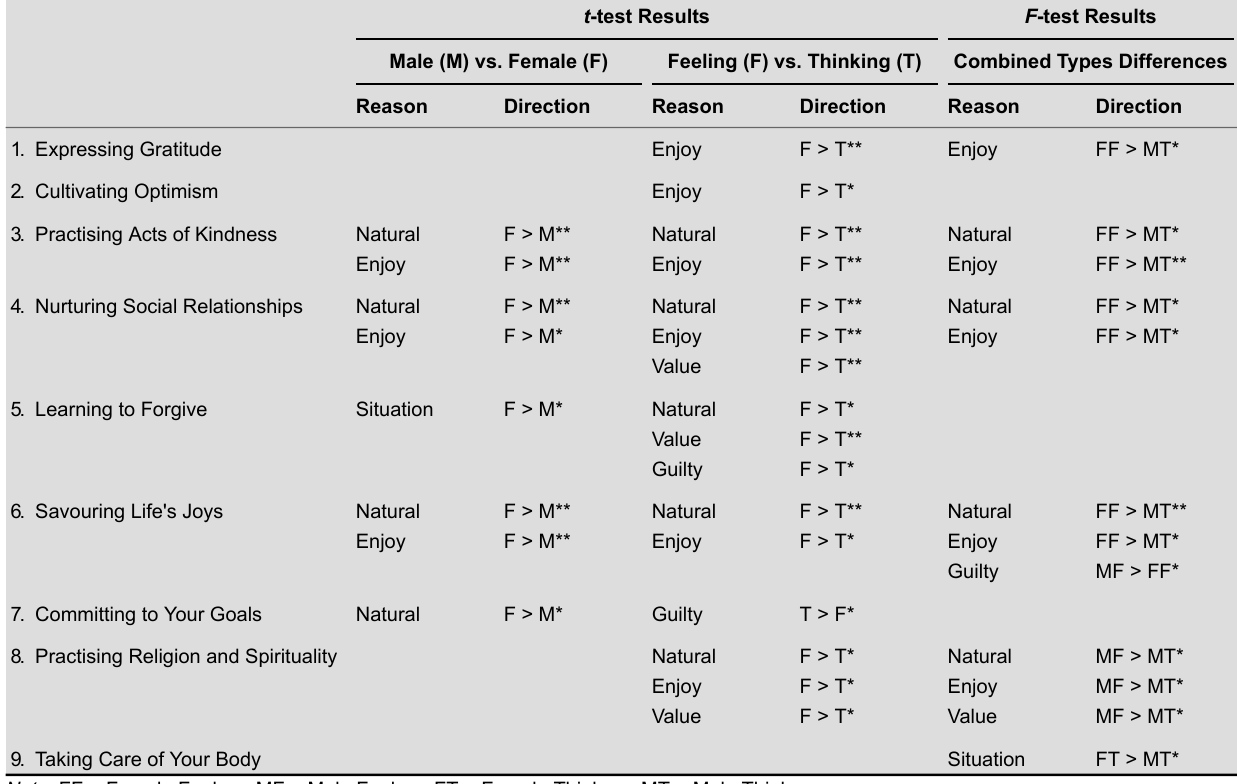
Significant Differences in Strategy Choice by Gender, Personality, and the Gender-Personality Interaction